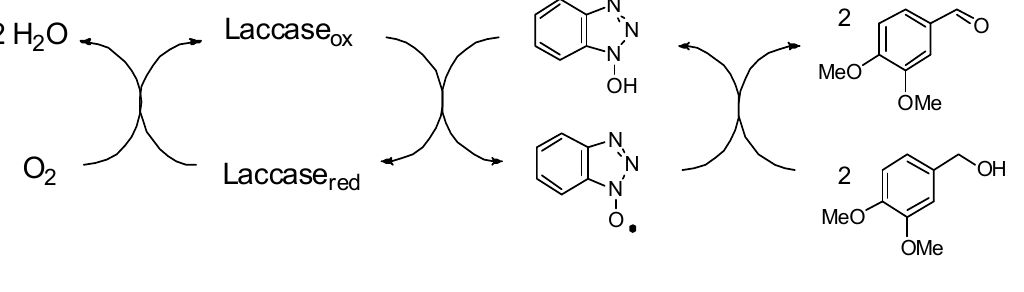
Figure 2. Laccase redox